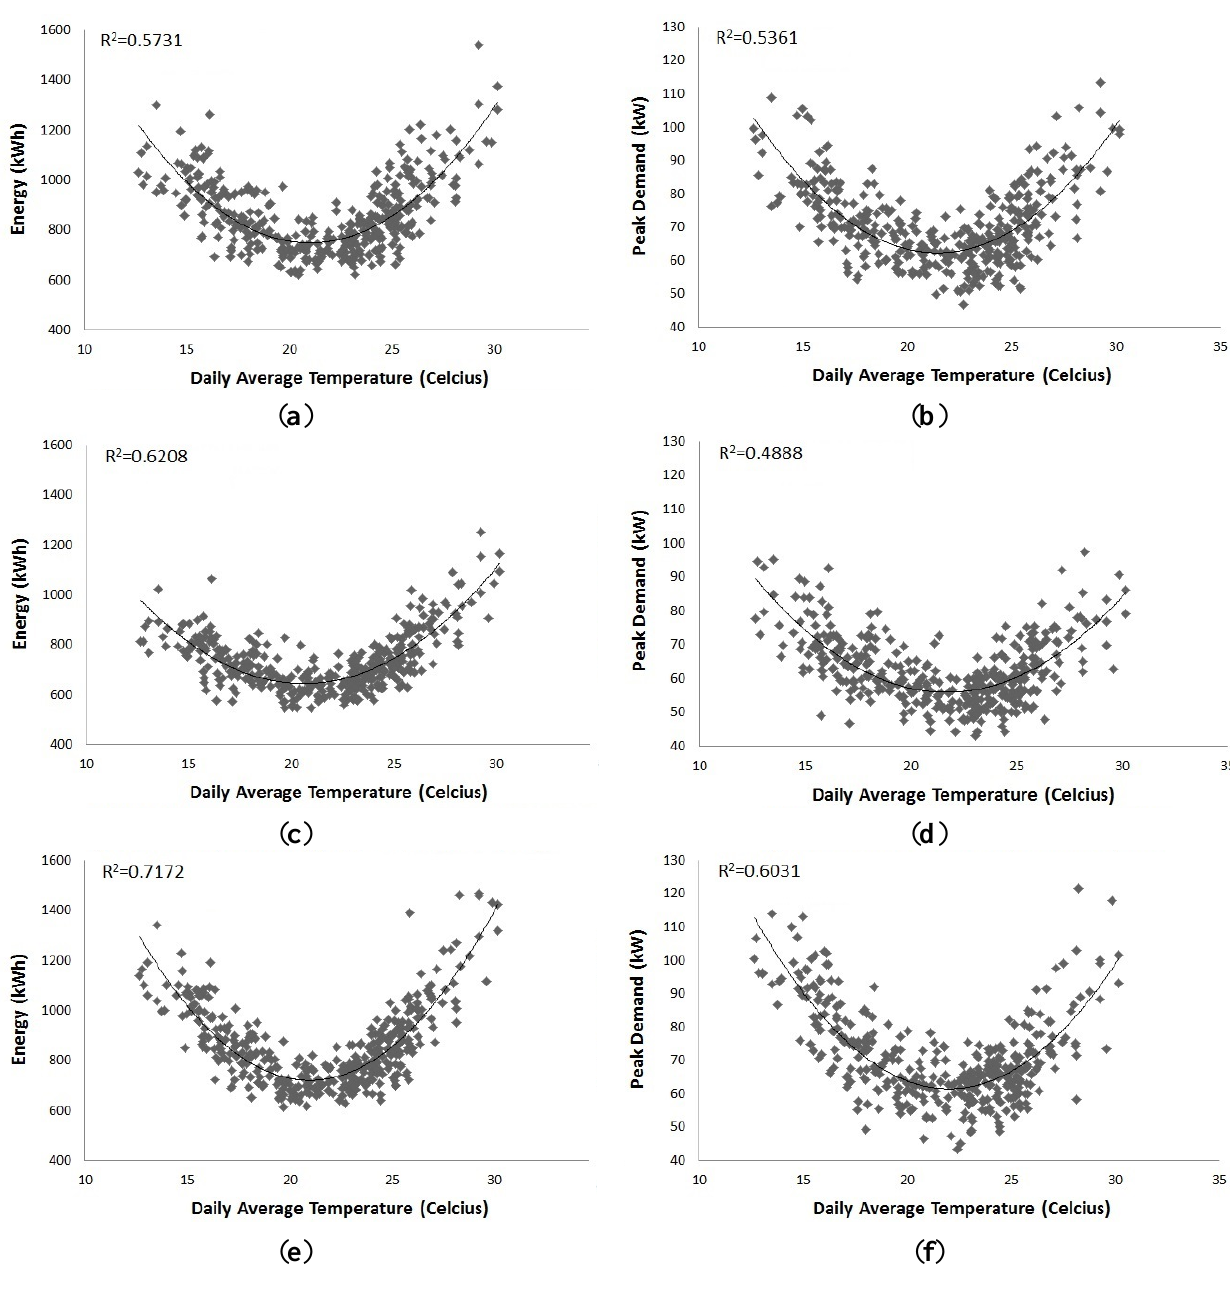
Figure 2. Demand response curves to temperature: ( a ) Phase 1: daily total energy use response; ( b ) Phase 1: peak demand response; ( c ) Phase 2: daily total energy use response; ( d ) Phase 2: peak demand response; ( e ) Phase 3: daily total energy use response; and ( f ) Phase 3: peak demand